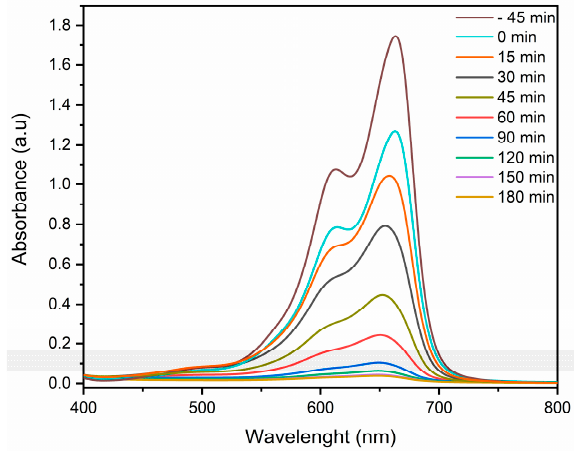
Figure 9. UV-vis absorption spectra changes of MB (10 mg/L) solution at various times by 40CaO-30 B 2 O 3 -30 V 2 O 5 (0.5 g/L).